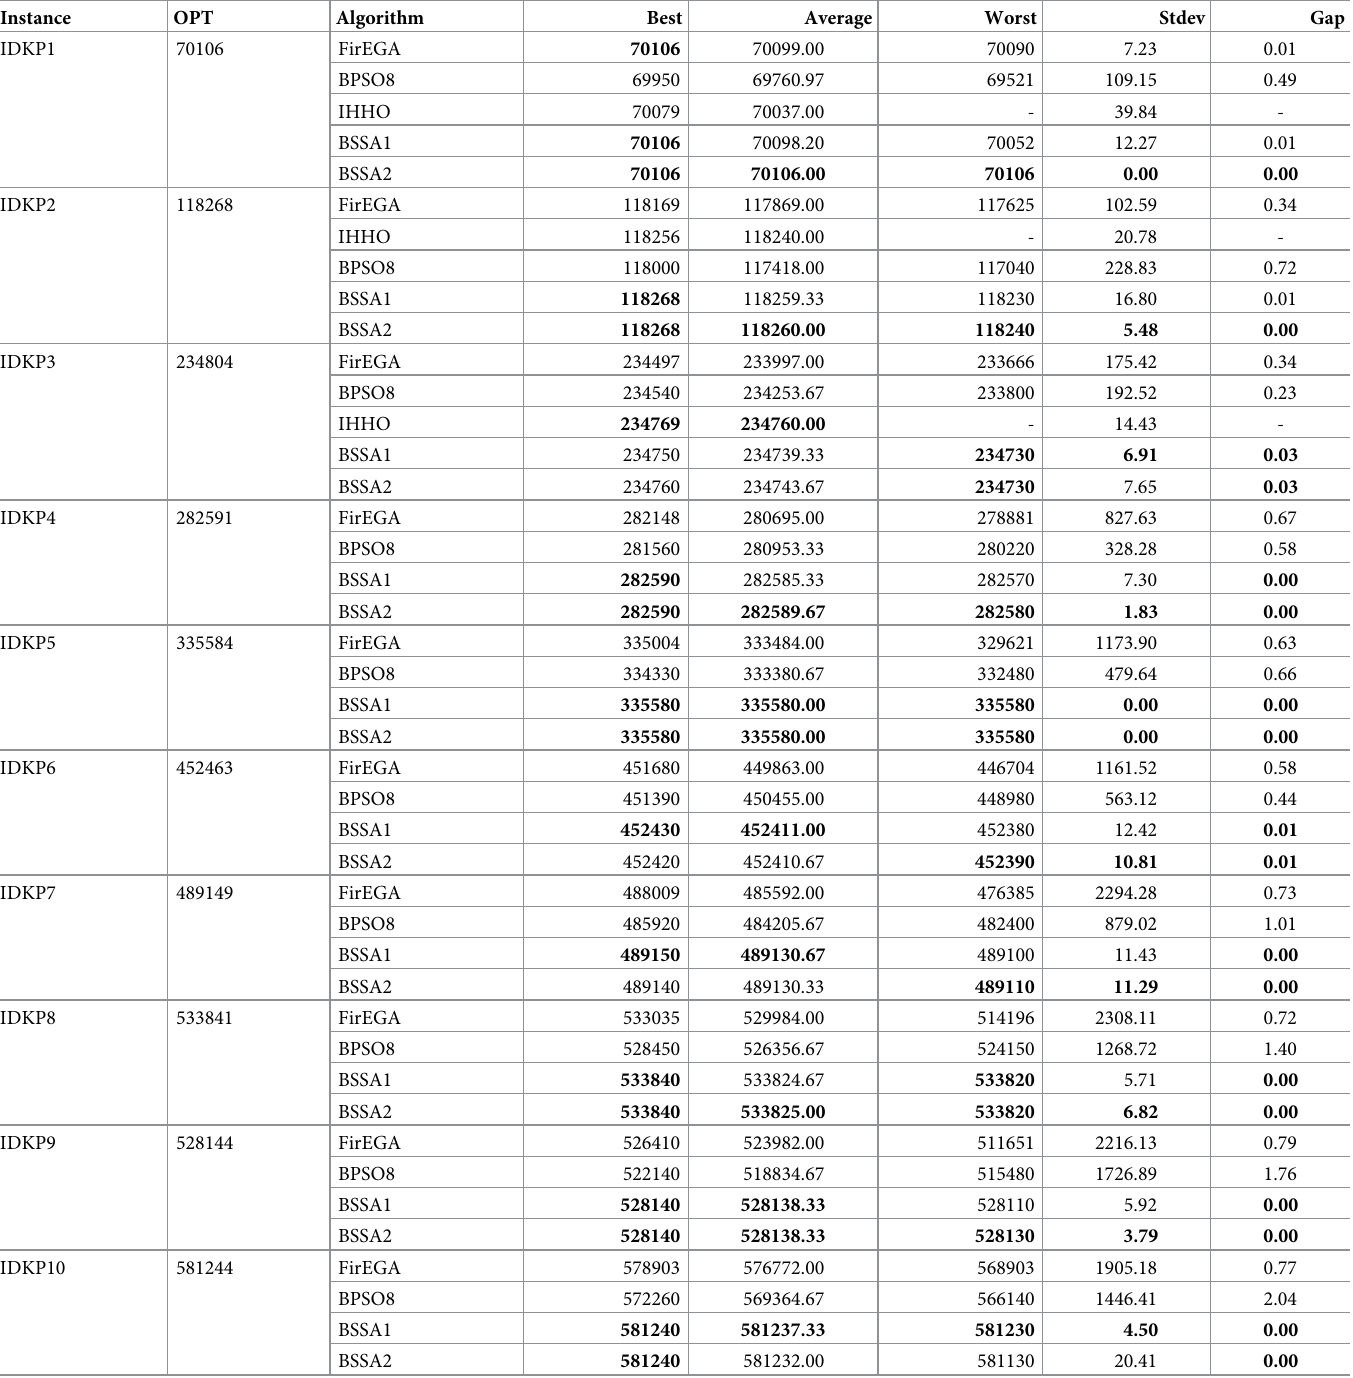
Table 5. Test results with inverse strongly correlated